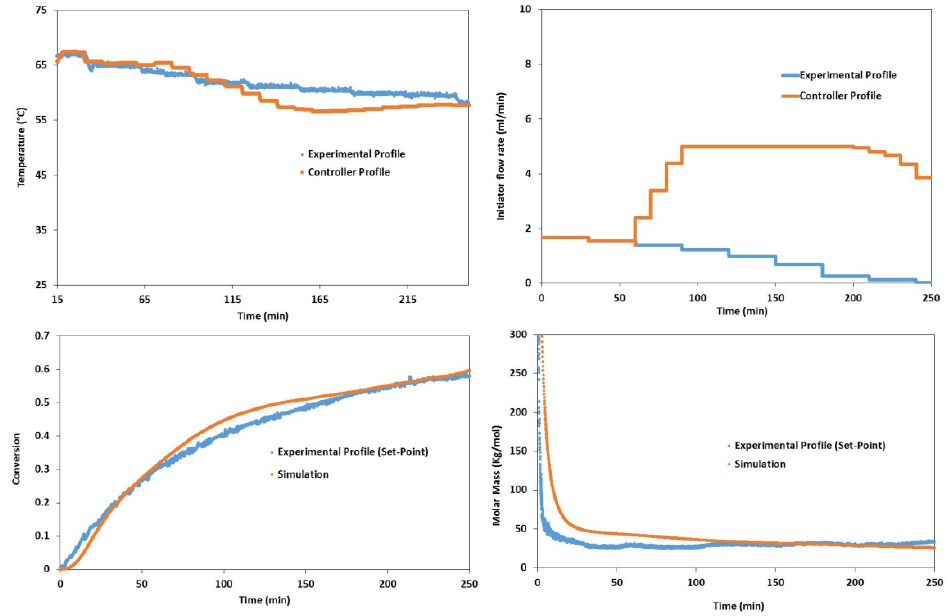
Figure 15. Closed-loop results for multi-loop controllers.